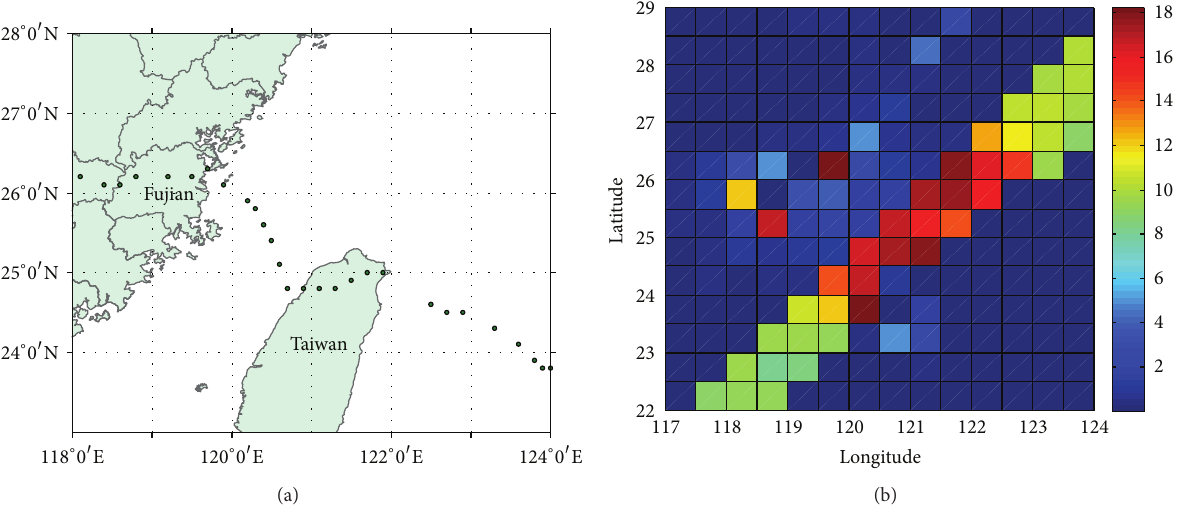
Figure 1: (a) Trajectory of Typhoon Soulik. The cycle refers to the core of Typhoon; (b) a snapshot of HY-2 satellite observed wind speed at the time of Typhoon Soulik landing the Fujian coastal region (units: